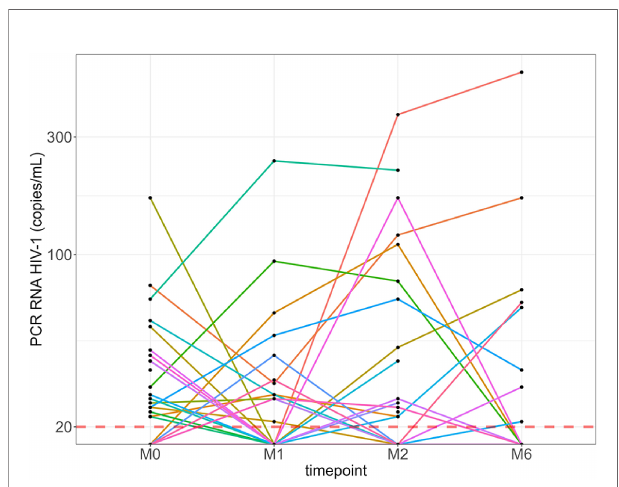
FIGURE 4 | Kinetics of HIV-1 RNA levels of each individual with detectable levels over 6 months. Red line: HIV-1 RNA quanti fi cation threshold (20 copies/ml). M0, at the fi rst dose; M1, 30 days after the fi rst vaccine dose; M2, 60 days after the fi rst vaccine dose; M6, 6 months after the fi rst vaccine